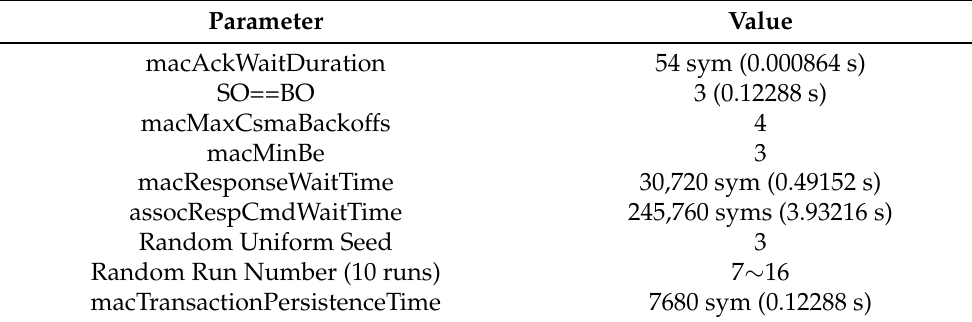
Figure 8. Example of grid topology used in association experiments (50 nodes, 1 coordinator). Table 1. Experiment